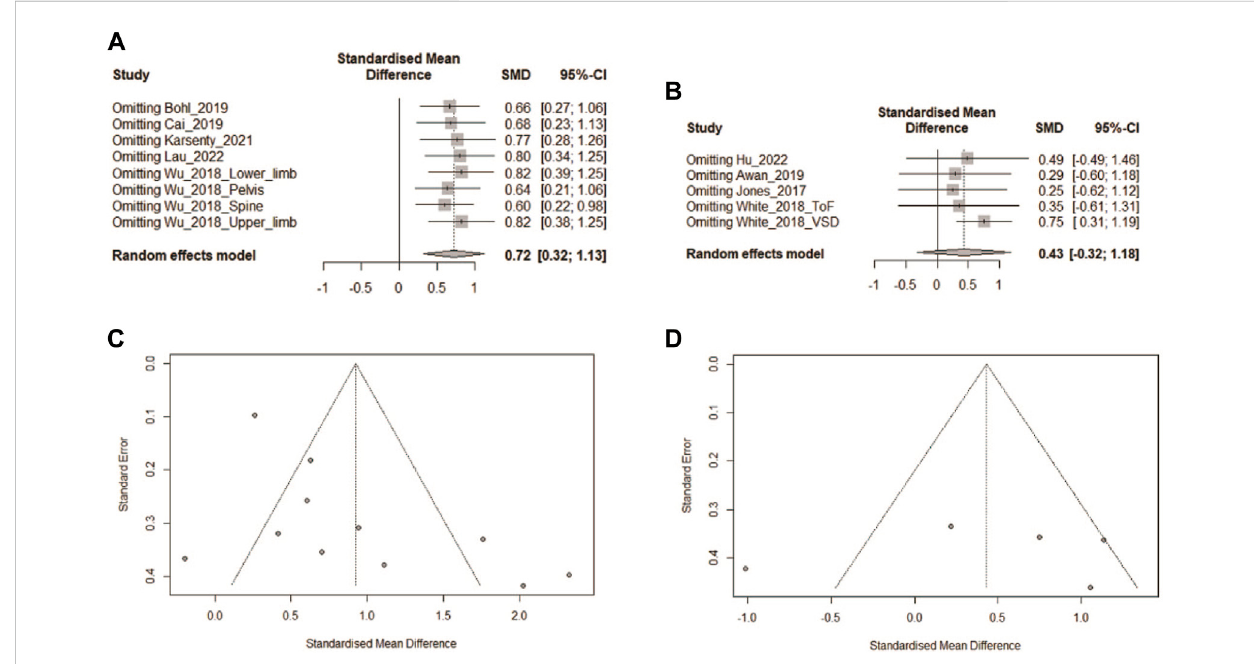
FIGURE 8 (A) The leave-one-out method was used to conduct an in fl uence analysis for the subgroup of medical students in 3.2.1. (B) The leave-one-out method was used to conduct an in fl uence analysis for the subgroup of medical students in 3.2.2. (C) Funnel chart for the student subgroup in 3.2.1. (D) Funnel chart for the student subgroup in 3.2.2.